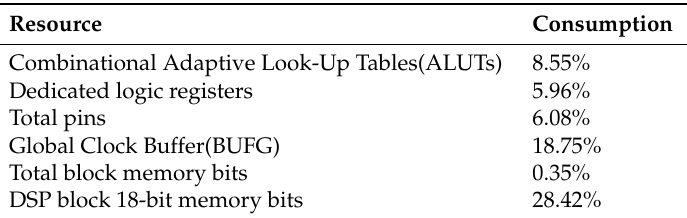
Table 3. Resource consumption in